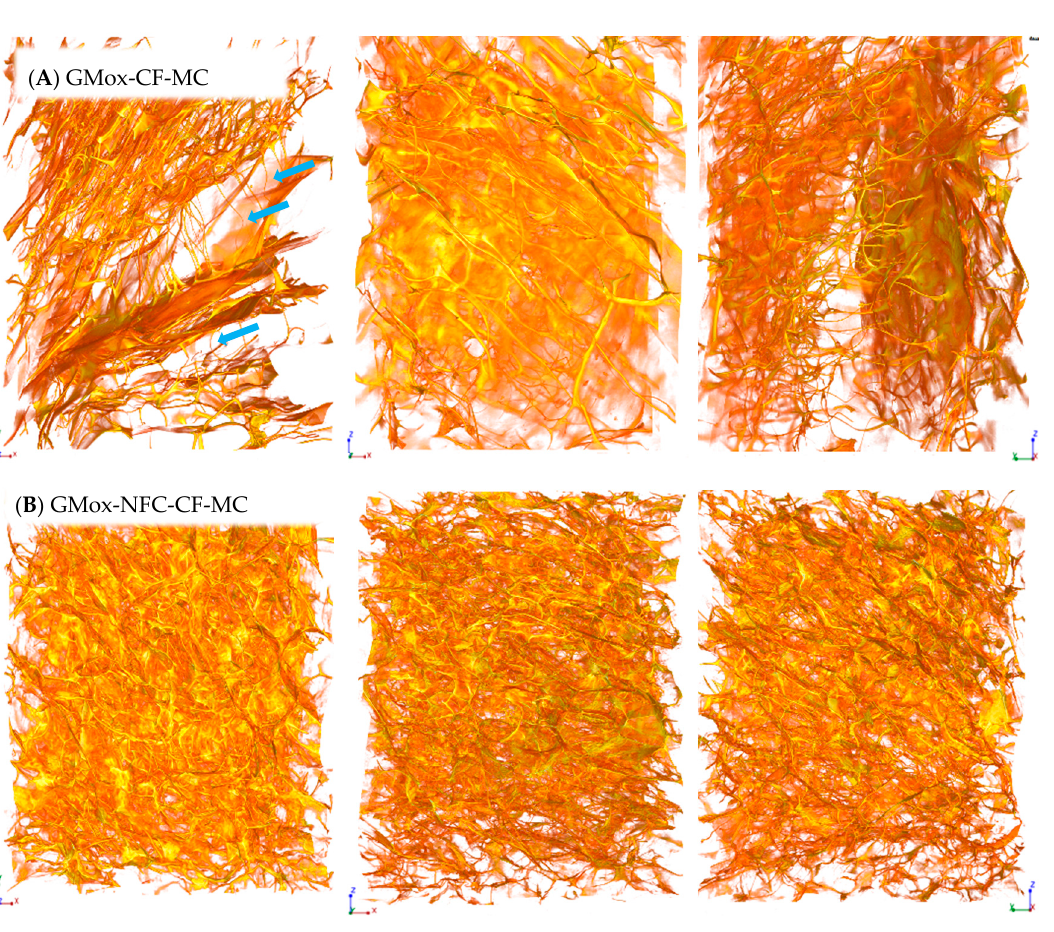
Figure 6. Three-dimensional reconstructed images from synchrotron phase contrast microtomography of ( A ) mechanically compressed (MC) oxidized GM (GMox-CF-MC) aerogel and ( B ) aerogel reinforced with 25% NFC (GMox-NFC-CF-MC), prepared by conventional freezing (CF). The size is 495.33 × 495.33 × 660.33 μ m 3 in XYZ-axis. Arrows indicate the observed buckling effect.